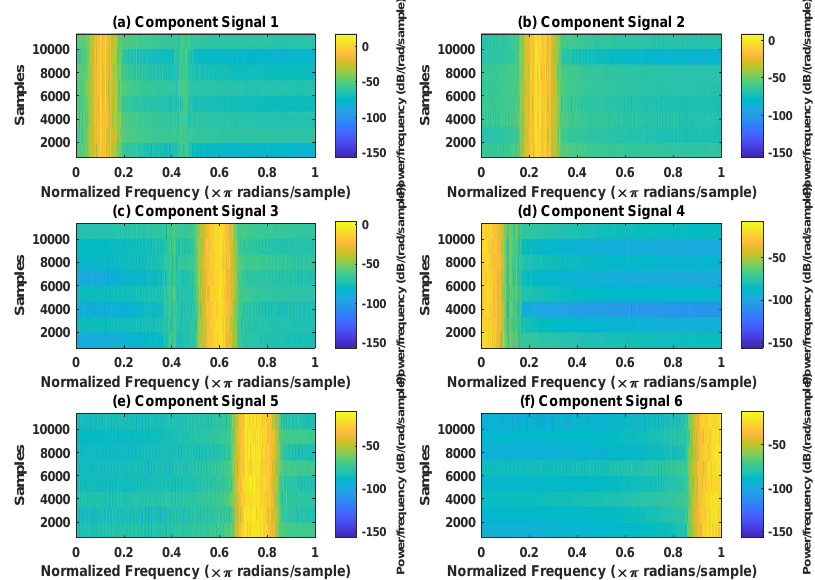
Figure 23. Decomposition results of ISVDP with m = 16 and J = 3: ( a – f ) time–frequency diagram of 1st to 6th subcomponents,